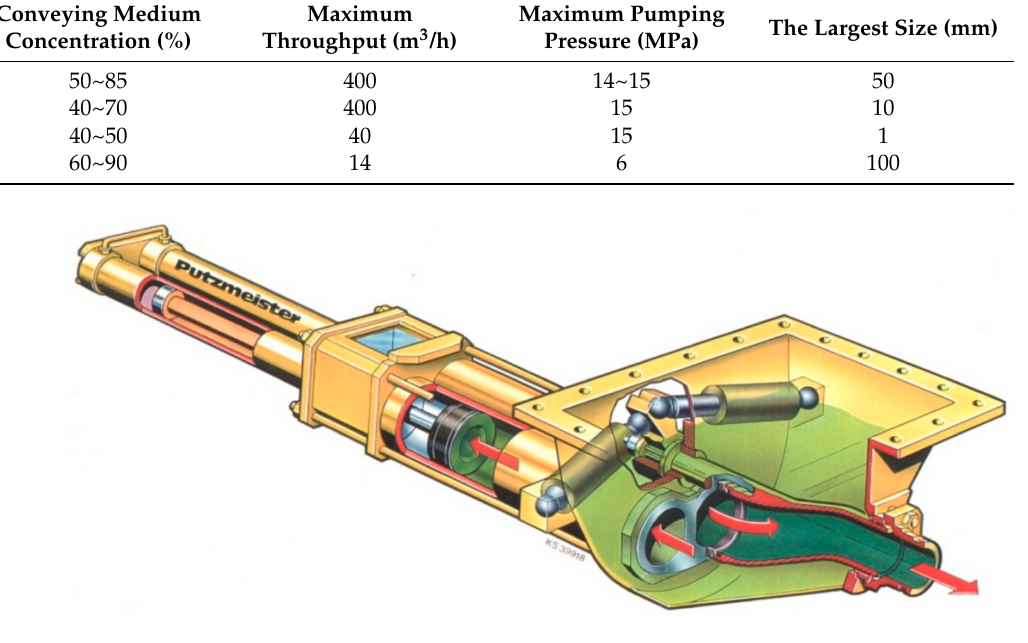
Figure 5. (Sourced from www.hnyuson.com, accessed on 12 November 2021). Schematic diagram of S tube valve series filling an industrial